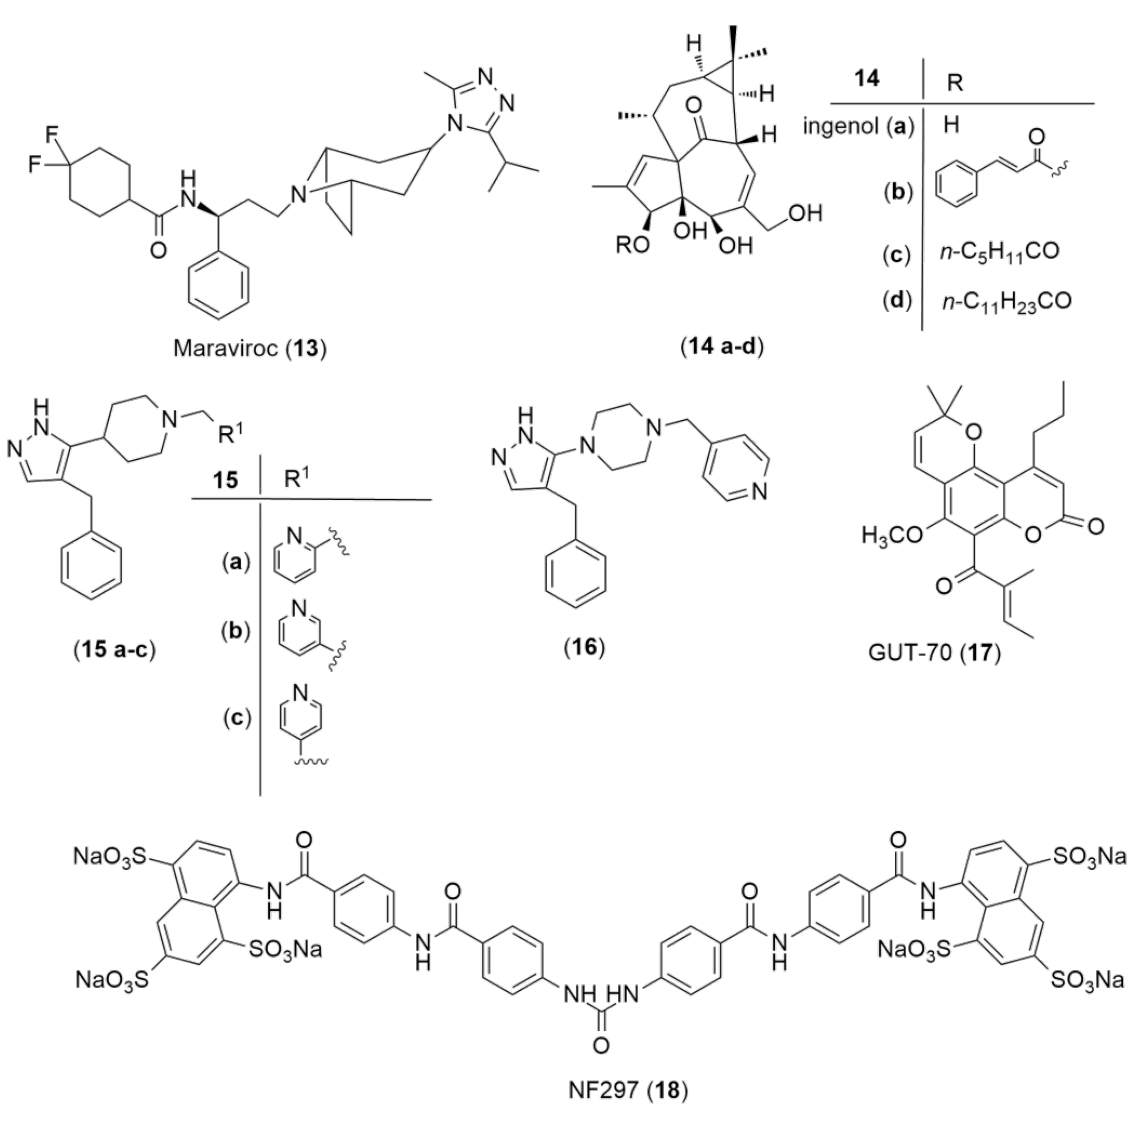
Figure 7. Host-based anti-HIV agents.